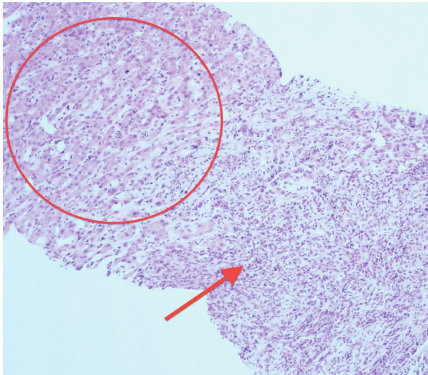
Figure 6: Photomicrographs (hematoxylin-eosin stain 100x magni- fication) of the liver biopsy specimens: normal hepatic parenchyma can be identified (circle) with cords of hepatocytes and normal portal spaces. Lymphocytic infiltration of the liver parenchyma can be identified (arrow) with some multinucleated cells (Langerhans cell).